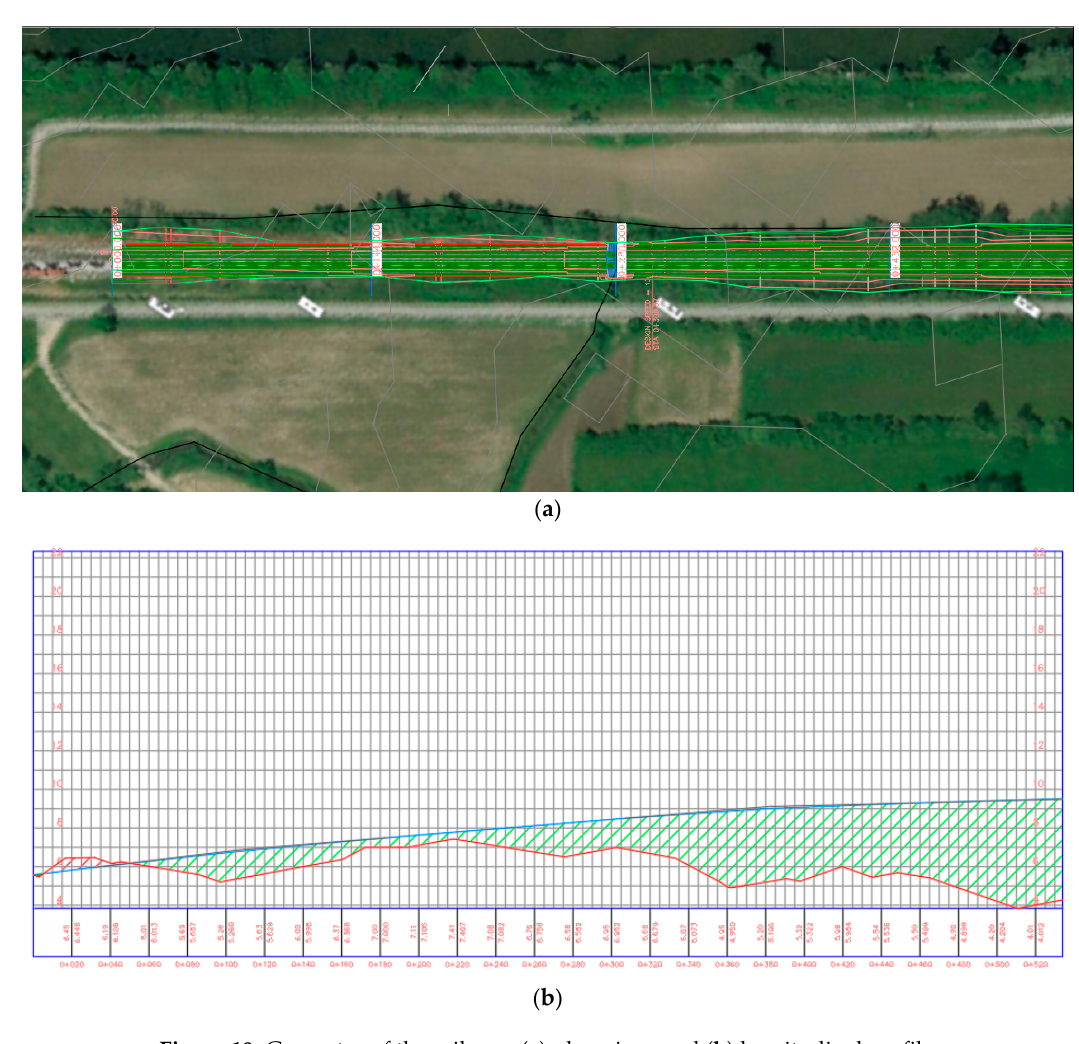
Figure 10. Geometry of the railway: (a) plan view; and (b) longitudinal profile.